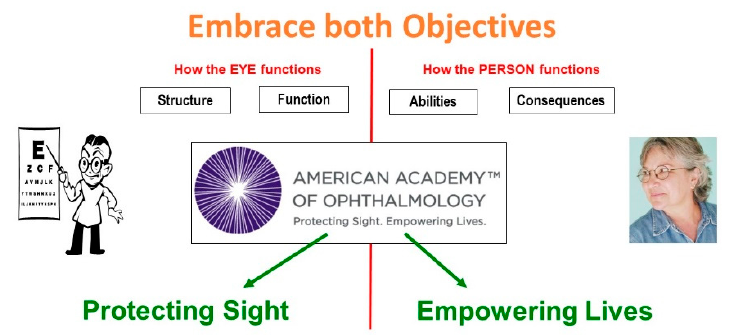
Figure 5. Factors in comprehensive vision rehabilitation.